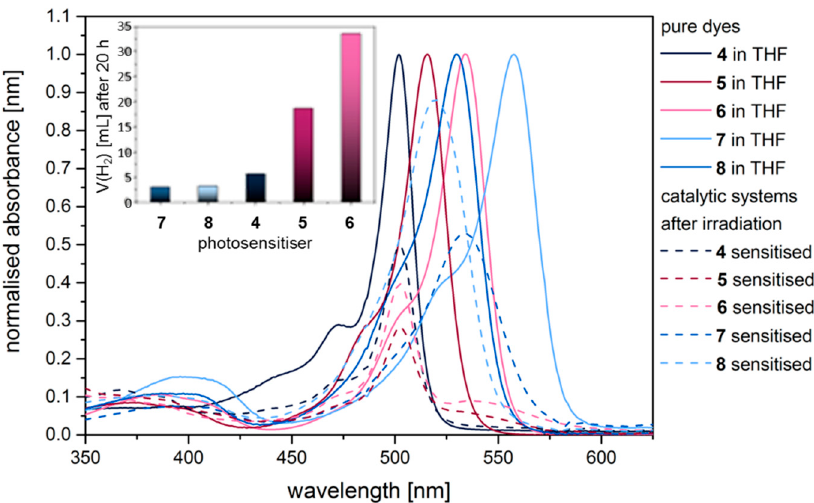
Figure 5. Absorption spectra of pure BODIPY dyes 4 – 8 before (solid line) and after (dashed line) irradiation in a multicomponent catalyst system for 16–200 h.